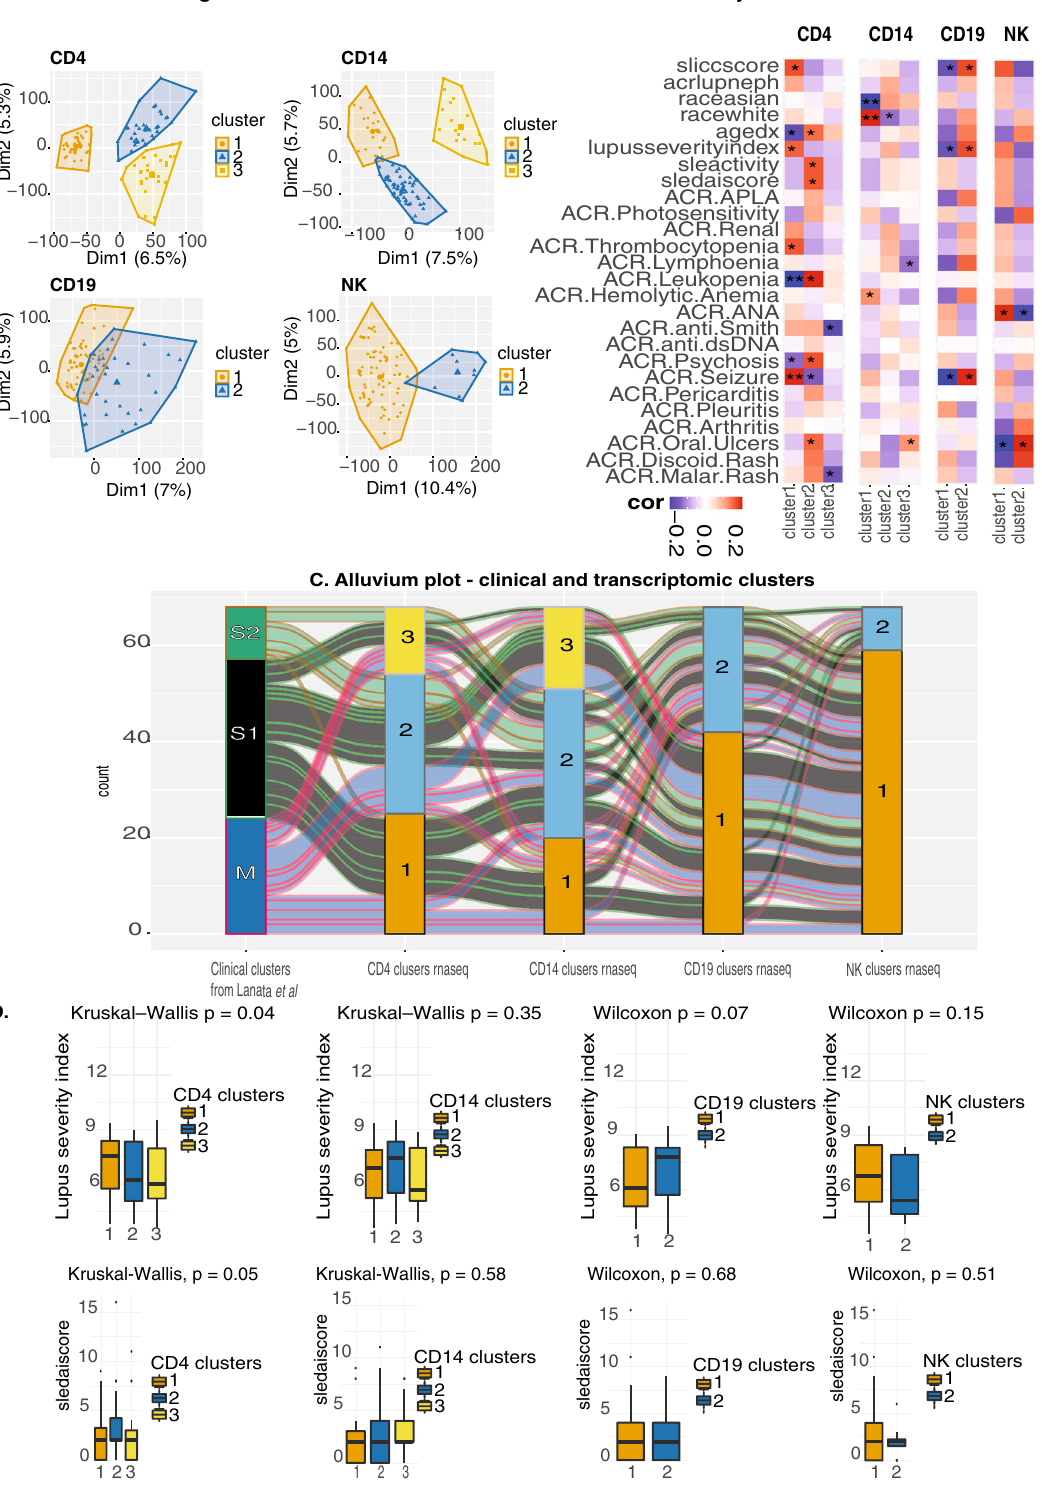
Fig. 2 K-means clustering analyses and correlation between transcriptomic clusters and clinical parameters including disease activity and ethnicity. A K-means clustering on the CD14 + monocytes, CD4 + T-cells, B cells, and NK cells. B Association analyses between clinical parameters and K-means s clustering. Red – positive association, blue – negative association. The number of stars indicates the level of signi fi cance. C Alluvium plot visualizing the distribution of the samples according to different clusters. D Distribution of lupus severity index and SLEDAI score across clusters with p -value computed using non-parametric